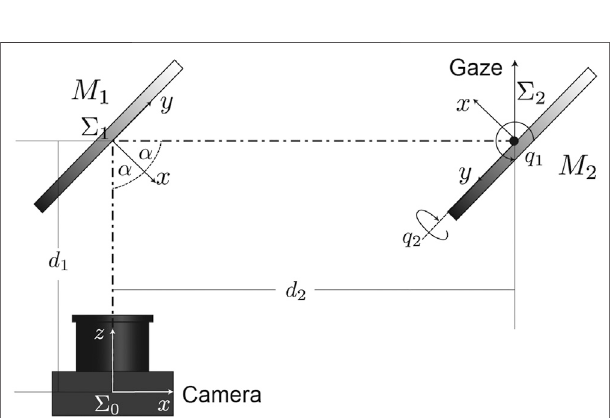
FIGURE3| Referenceframesofthesystem.Sinceweassumeasystem of fi xed cameras on the robot, we consider a frame Σ 0 at the origin of the camera. The origins of the frames Σ 1 and Σ 2 are located in the center of the mirrors 1 and 2 , respectively.